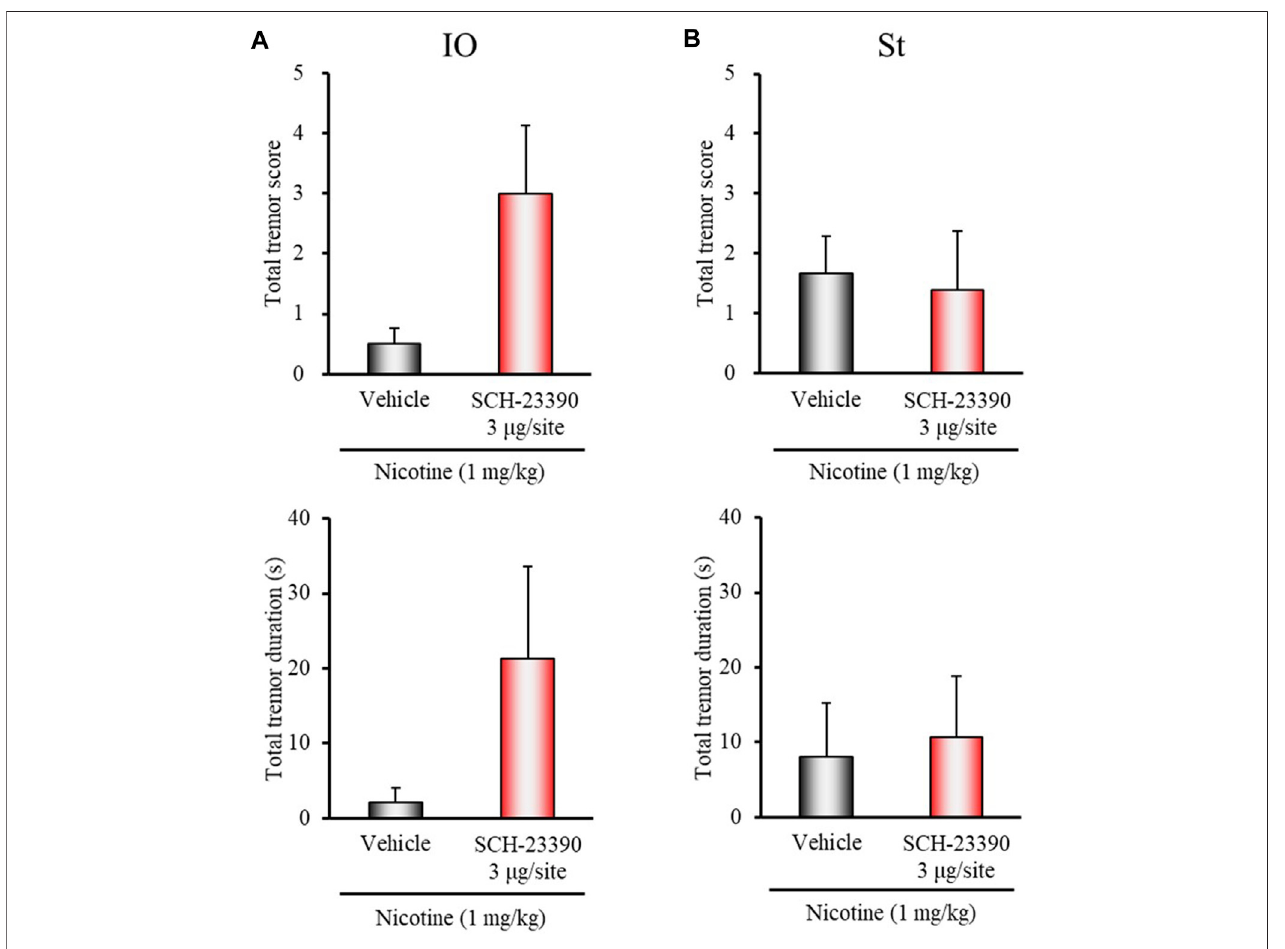
FIGURE4| EffectsofbrainmicroinjectionofSCH-23390onnicotine-inducedtremorinrats.TheD 1/5 antagonistSCH-23390(3 μ g/injectionsite)orvehicle(control) wasinjected into: (A) IO or (B) the striatum (St) in rats 15 min before the nicotine (1 mg/kg, i.p.) injection. Datashow the total tremor score (intensity) and duration ofnico tine-induced tremor during the 5 – 16 min observation period. Each column represents the mean ± S.E.M.